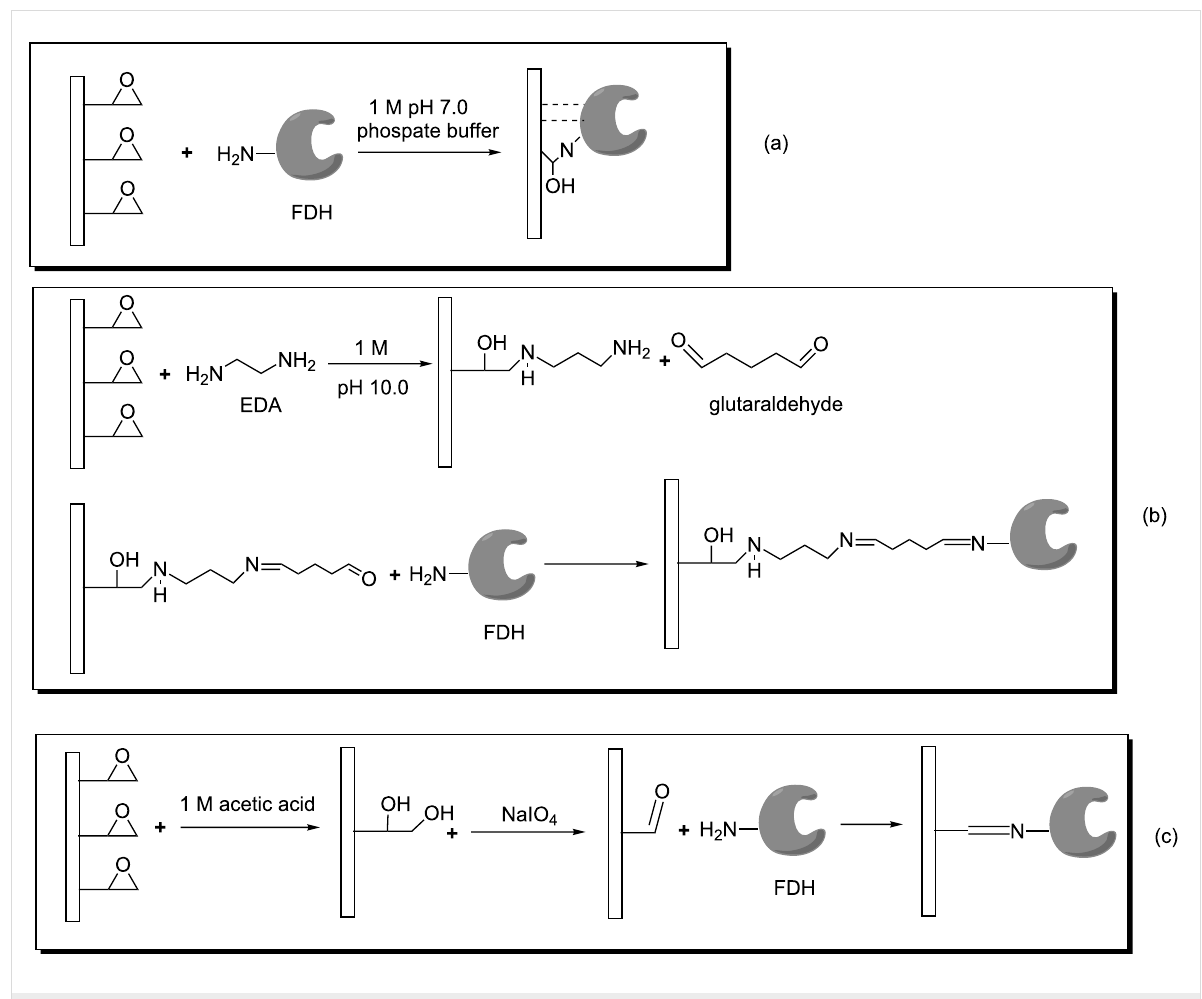
Figure 1: The immobilization scheme of FDH onto Immobead 150 and modified Immobead 150 supports.